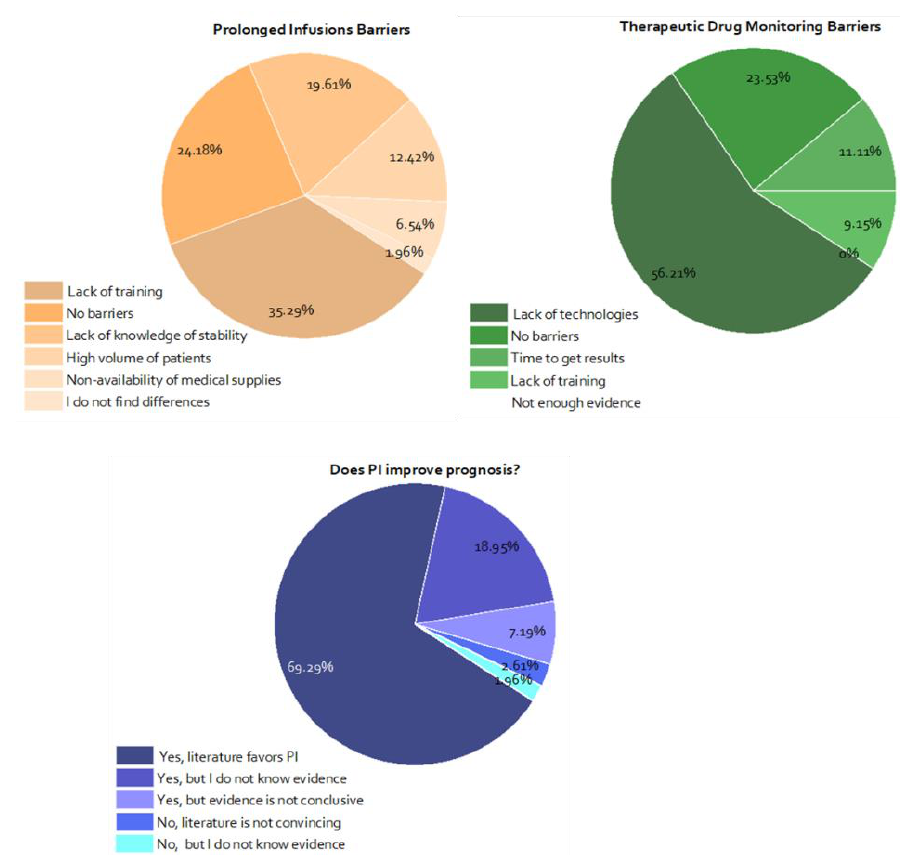
Figure 3. Perception of specialists on types of barriers related to prolonged infusions, TDM, and knowledge of the evidence. PI: prolonged infusions, II: intermittent infusions. Table 2. Bivariate analysis of approaches to clinical